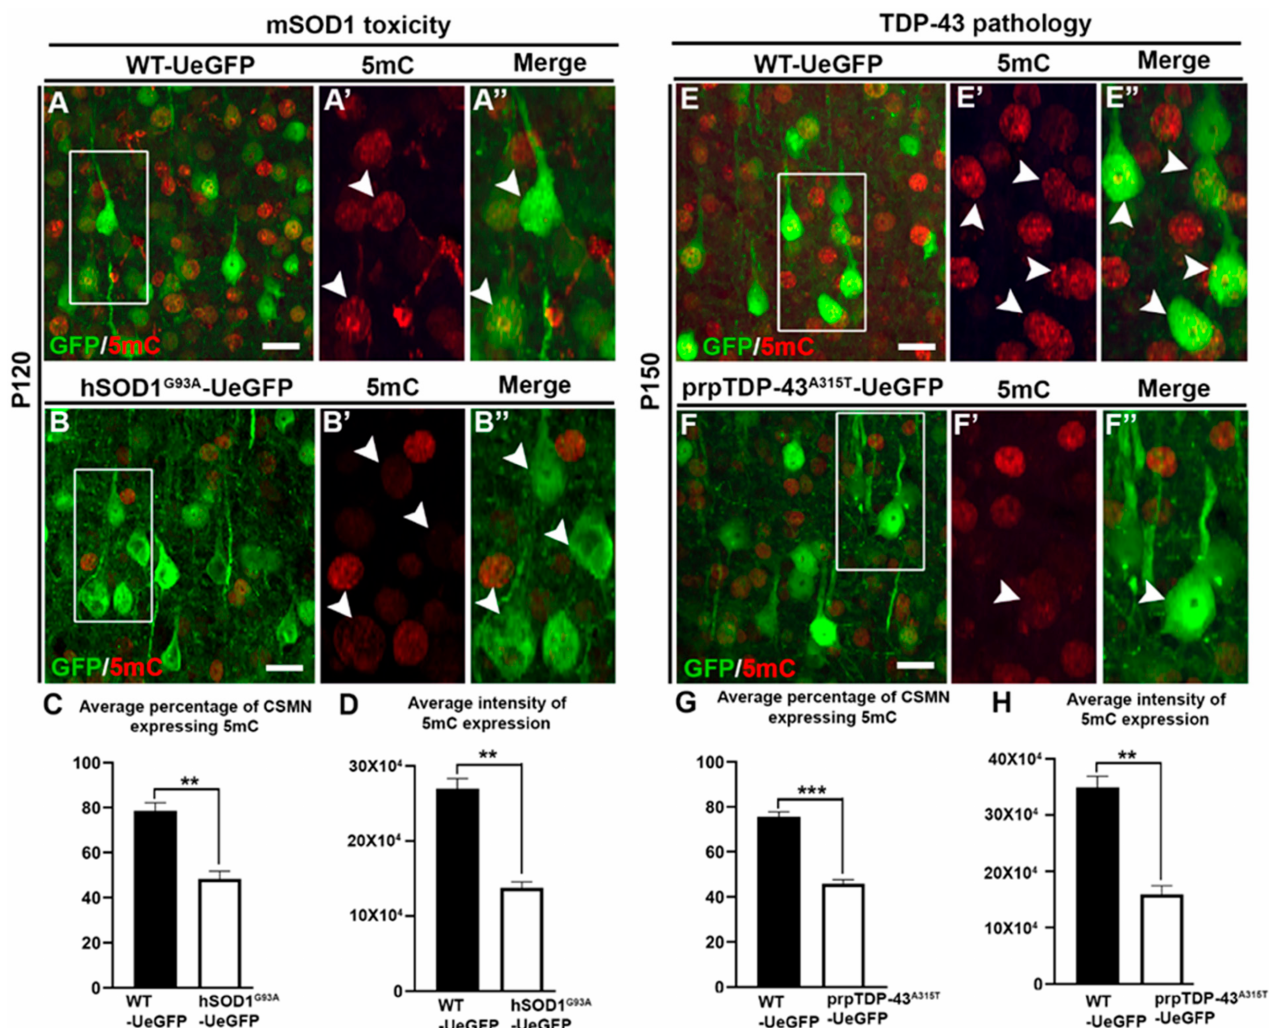
Figure 1. CSMN that are vulnerable in ALS due to different underlying causes display reduced levels of 5-methylcytosine (5mC). ( A ) Representative image of layer V of motor cortex from WT-UeGFP mouse at P120 showing GFP labelled CSMN and 5mC expression. Box enlarged ( A (cid:48) , A (cid:48)(cid:48) , arrow heads). ( B ) Representative image of layer V of motor cortex from hSOD1 G93A -UeGFP mouse at P120 showing GFP labelled CSMN and 5mC expression. Box enlarged ( B (cid:48) , B (cid:48)(cid:48) , arrow heads). ( C ) Quantitative analysis of average percentage of CSMN expressing 5mC in hSOD1 G93A -UeGFP mouse at P120. ( D ) Quantitative analysis of average intensity of 5mC expression in CSMN of hSOD1 G93A -UeGFP mouse at P120. ( E ) Representative image of layer V of motor cortex from WT-UeGFP mouse at P150 showing GFP labelled CSMN and 5mC expression. Box enlarged ( E (cid:48) , E (cid:48)(cid:48) , arrow heads). ( F ) Representative image of layer V of motor cortex from prp-TDP- 43 A315T -UeGFP mouse at P150 showing GFP labelled CSMN and 5mC expression. Box enlarged ( F (cid:48) , F (cid:48)(cid:48) , arrow heads). ( G ) Quantitative analysis of average percentage of CSMN expressing 5mC in prp-TDP-43 A315T -UeGFP mouse at P150. ( H ) Quantitative analysis of average intensity of 5mC expression in CSMN of prp-TDP-43 A315T -UeGFP mouse at P150. ** p < 0.001, *** p < 0.0005; Scale bar: 20 µ